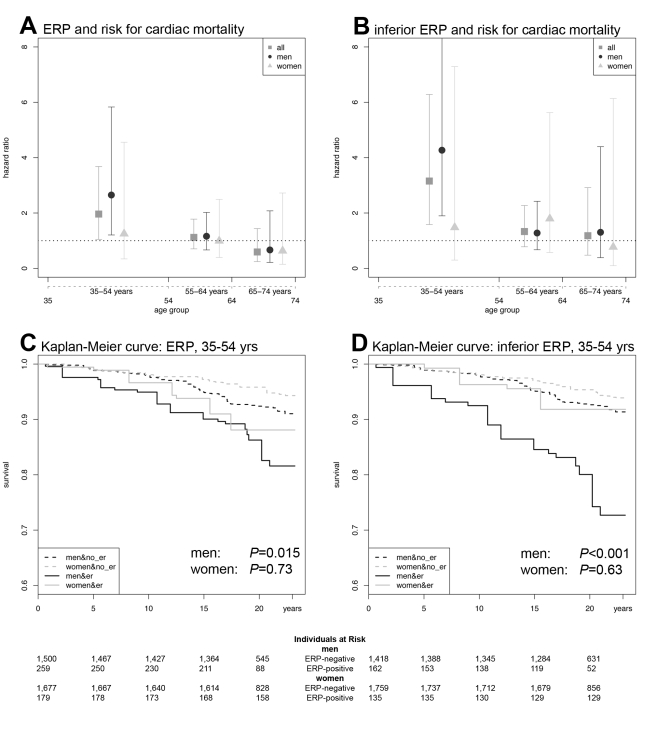
ERP effects on cardiac mortality.(A) HRs and CIs for ERP in any localization. (B) HRs and CIs for the analysis restricted to ERP in an inferior localization. In both (A) and (B), the symbols illustrate the effect size as derived from an age-stratified analysis in younger (35–54 y), middle-aged (55–64 y), and older (65–74 y) participants. Comparing (A) and (B), the ERP-attributable effect is more pronounced if localized in inferior leads. The lower panels show Kaplan-Meier curves for cardiac mortality depending on the presence of ERP and sex in the subgroup of younger individuals (35–54 y). (C) Kaplan-Meier curves for ERP in any localization. (D) Kaplan-Meier curves for ERP in an inferior localization. Men with ERP show the highest cumulative hazard. The effect of ERP on cardiac mortality is stronger in men and outweighs the sex-attributable effect. ERP-attributable effects tend to start earlier in men than in women. Again, effects are stronger, restricting the analysis to an inferior localization of ERP. p-Values in (C and D) were derived by a weighted Cox proportional hazards model. The numbers of individuals at risk are listed below each Kaplan-Meier plot.